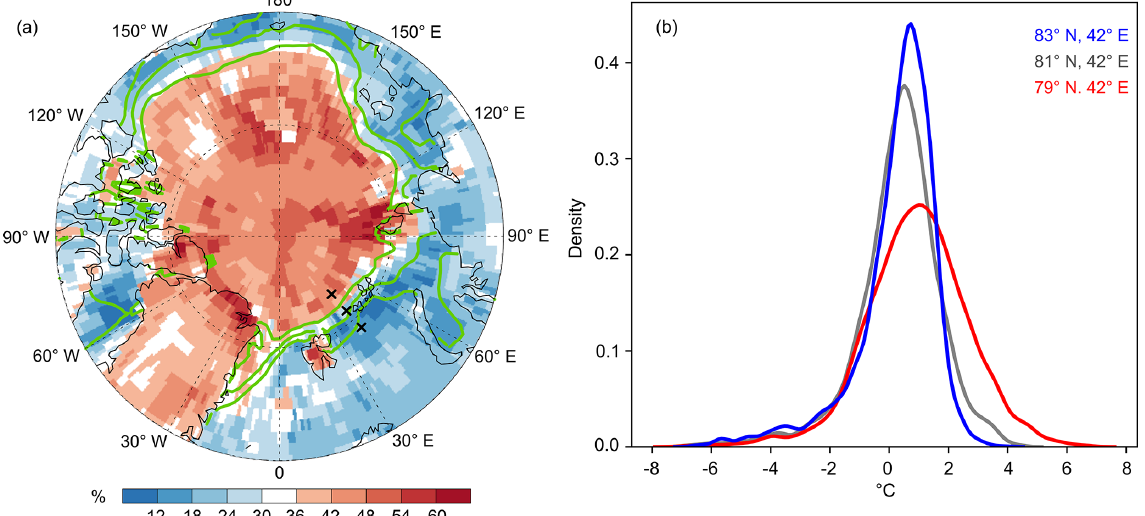
Figure 9. Arctic sea ice and local summer temperature variability. (a) XF ERAI (shading; only 70 ◦ N–90 ◦ N is shown) and mean 1979–2018 cold JJA ERA-Interim sea ice concentration (green contours indicate sea ice concentrations of 0.3, 0.5 and 0.7). (b) Empirical probability density function of non-detrended ERA-Interim T2m at 79 ◦ N, 42 ◦ E (red); 81 ◦ N, 42 ◦ E (grey); and 83 ◦ N, 42 ◦ E (blue). Crosses in panel (a) locate these three grid points.